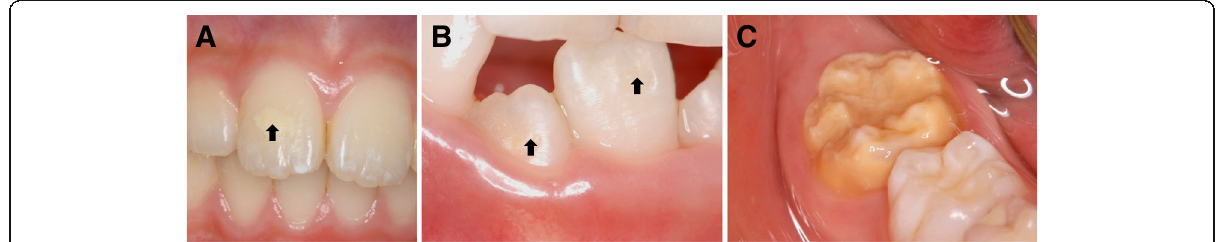
Fig. 2 Tooth surface defects were categorized as follows: a none, b enamel defect, and c dentin